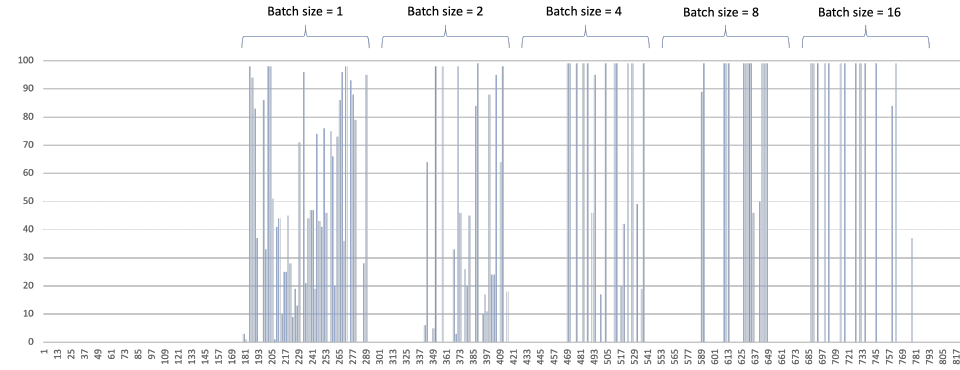
Figure 7. GPU resource usage with different batch size.